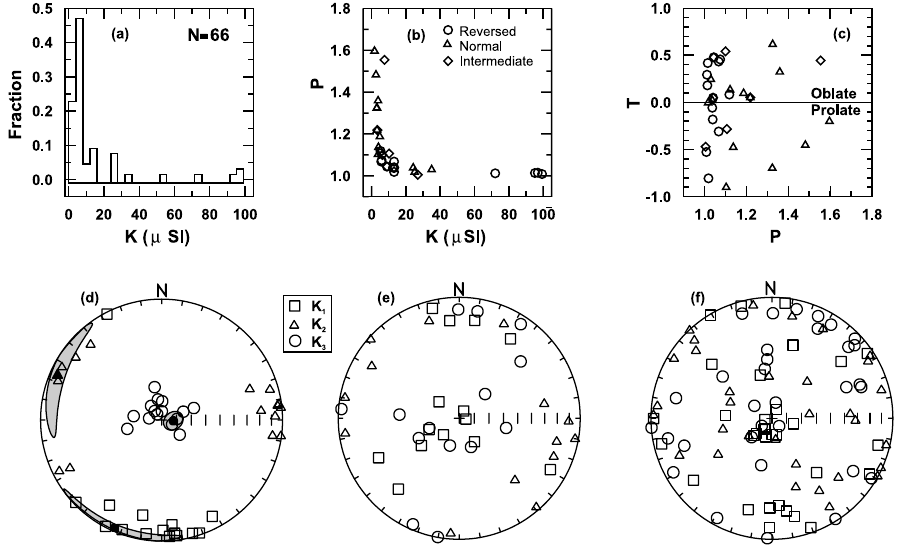
Fig. 7 – (a) Histogram of bulk magnetic susceptibility of 66 Botucatu samples. (b) Degree of anisotropy (P) versus bulk susceptibility. (c) Shape parameter (T) versus P. Equal are projection of principal susceptibility axes for reversed (d), normal (e) and transitional (f) samples. In the (d) diagram the 95% confidence ellipses are shown.